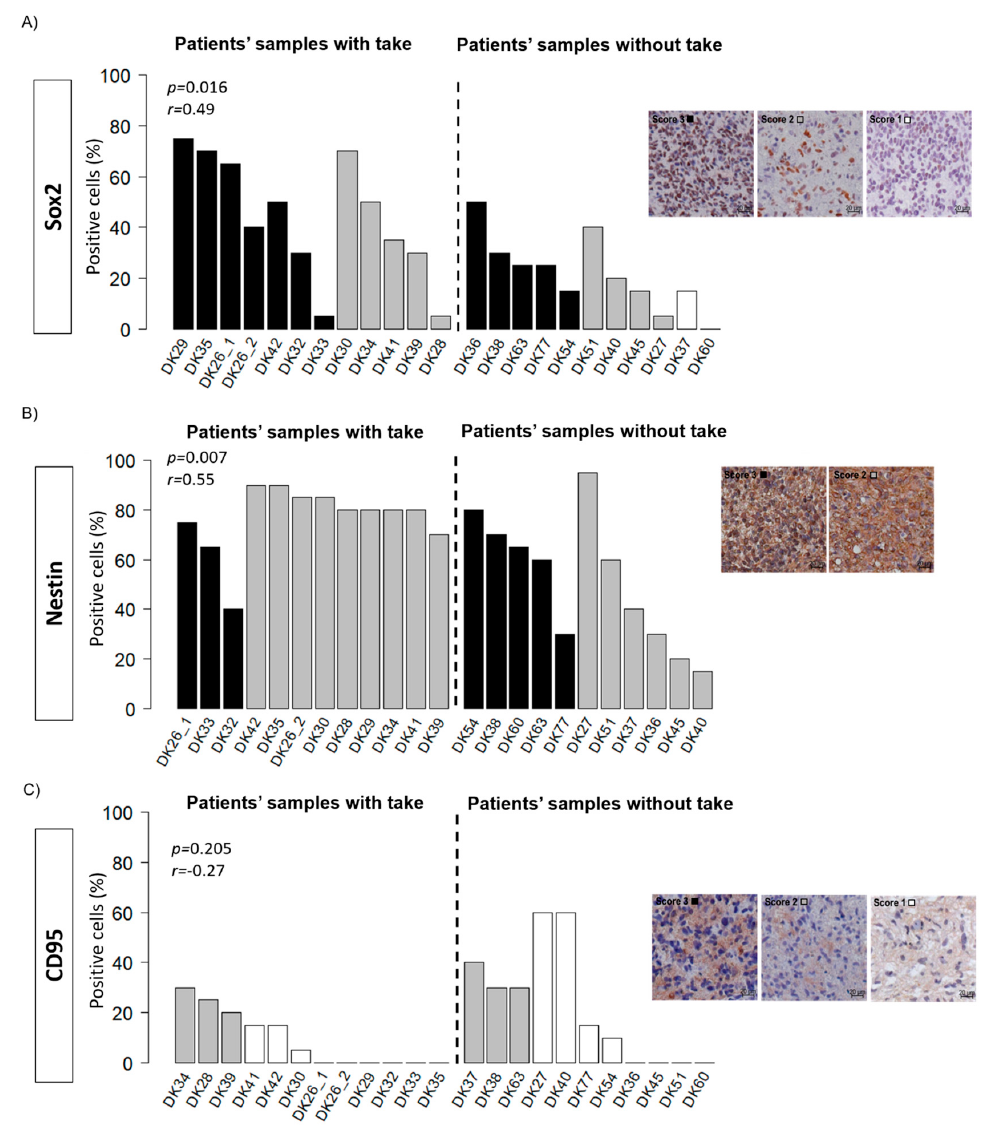
Figure 6. Putative cancer stem cell markers in the patient material. ( A ) The stainings were evaluated by two independent observers. ( B ) The proportion of positive cells (0–100%) and the intensity of the staining (0–3) were assessed (negative: intensity score 0, white: intensity score 1, grey: intensity score 2, black: intensity score 3). ( C ) Association between the proportion of positive cells and the take in the first generation were analysed; results ( p -value and coe ffi cient of correlation (Spearman)) are presented in the